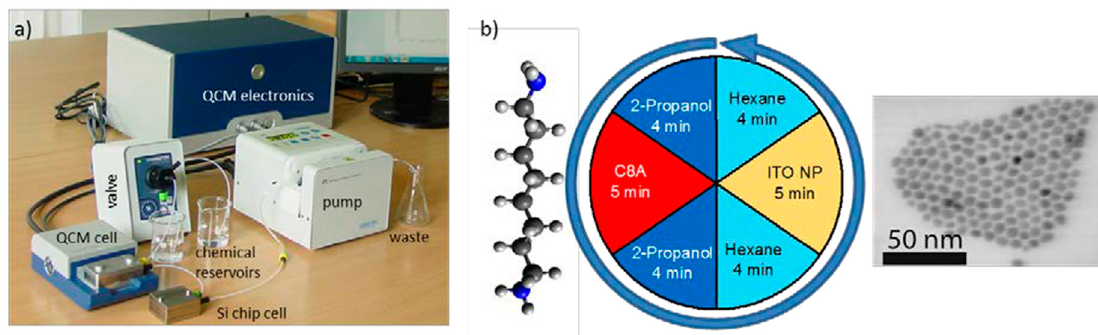
Figure 1. ( a ) Automated layer-by-layer self-assembly setup (including Q-Sense QCM-D E1); ( b ) assembly cycles with structure of organic linker (1,8-Diaminooctane, C8A) and STEM image of ~7 nm Indium-Tin-Oxide (ITO) nanoparticles.